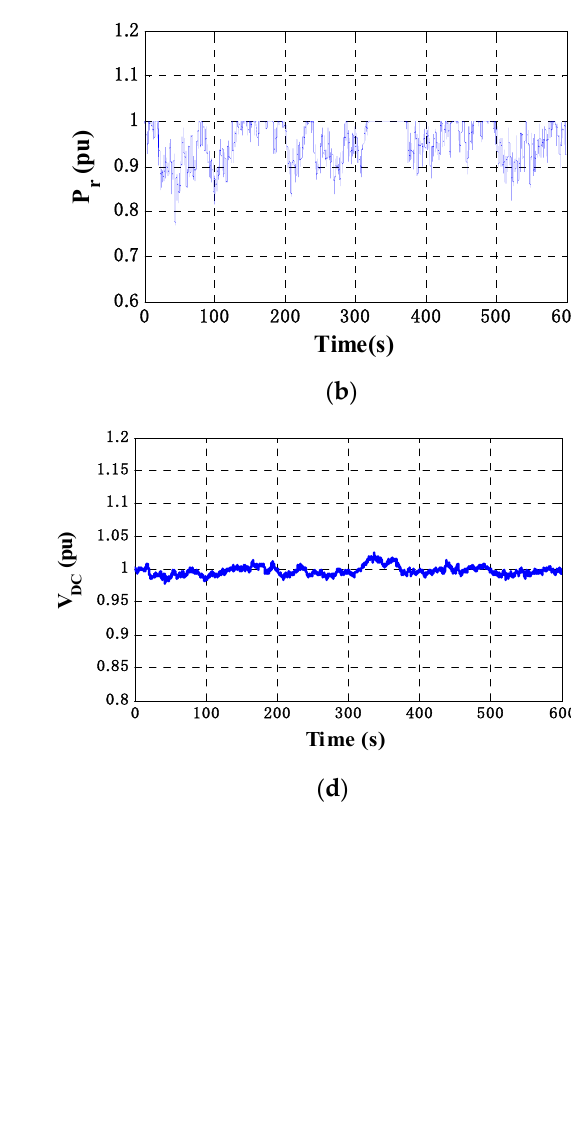
( f ) Figure 14. Simulation curves for L ‐ G fault using the AOA, the GA, and PSO: ( a ) terminal voltage; ( b ) P curve; ( c ) Q curve; ( d ) DC link voltage curve; ( e ) SMES ‐ injected active power; ( f ) SMES ‐ injected reactive power. 5.5. Normal System Scenario For obtaining authentic system outputs, actual information of wind speed captured from the Zafarana wind farm in Egypt was used, as depicted in Figure 15. The duration of the simulation was 600 s. From the simulation results, it can be clearly noticed that the actual PCC voltage re ‐ sponse has many fluctuations and does not have a smooth response. Figure 15b illustrates the active power (P) response, which is clearly not stable and fluctuates over time, with a negative impact on the system’s response. Figure 15c depicts the reactive power ( Q ) re ‐